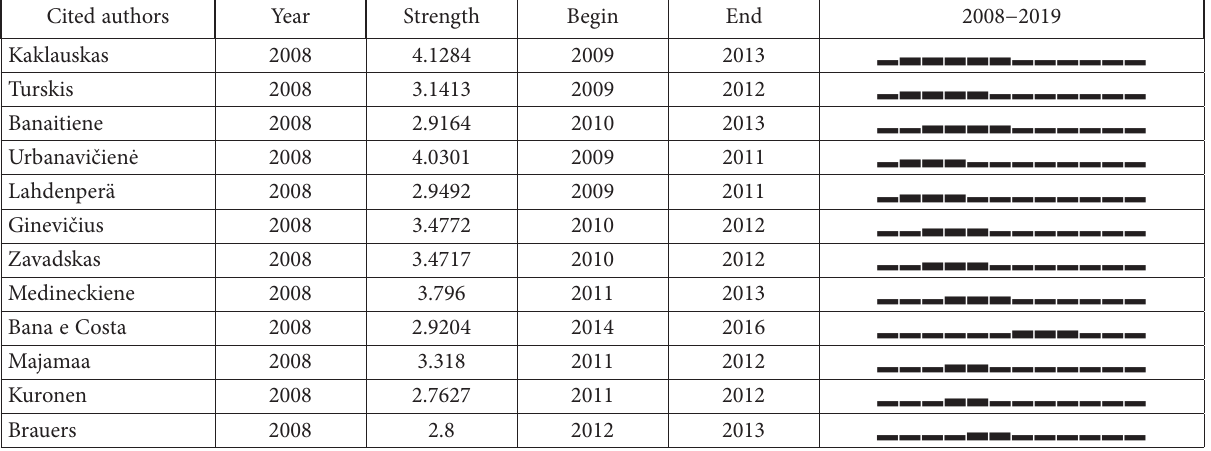
Table 8. Top 12 cited authors with the strongest citation bursts in the IJSPM from 2008 to 2019